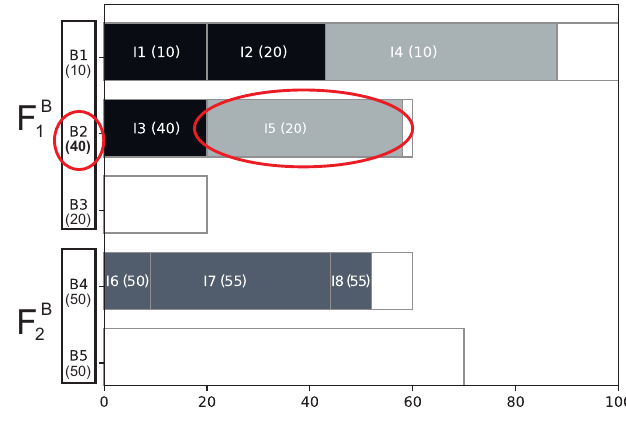
Figure 6. Solution to a simple problem where B 2 is